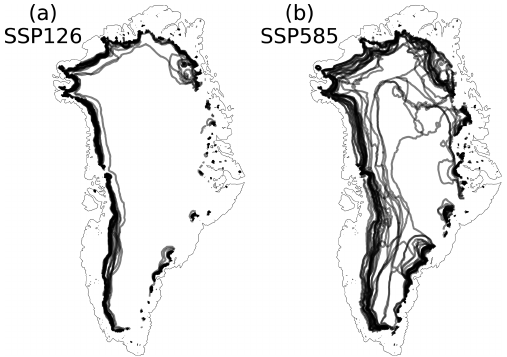
Figure 4. Equilibrium lines of the median SMB over all parame- ter combinations (temporal mean for the period of 2090–2099) for different ESMs and the scenarios SSP126 (a) and SSP585 (b)